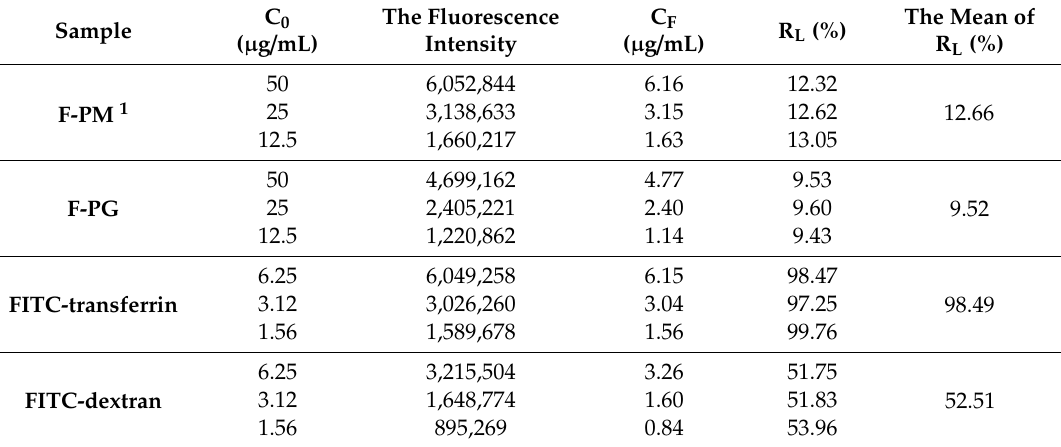
Table 4. The R L (%) of F-PM and